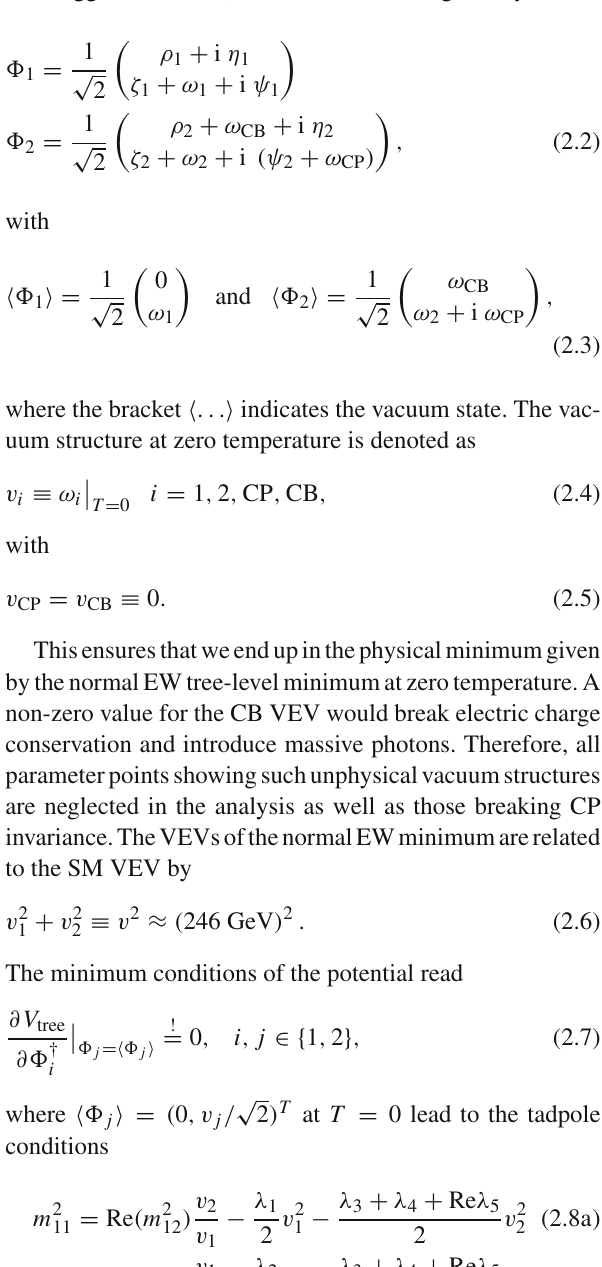
Table 1 Left: definition of the 2HDM types through the allowed cou- plings between fermions and Higgs doublets. Right: corresponding Z 2 parity assignments to the left-handed quark and lepton doublets, Q , L , and the right-handed singlets of the up-type and down-type quarks, u R and d R , and right-handed leptons l